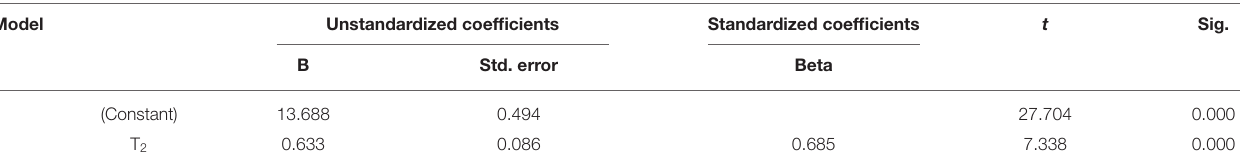
TABLE 7B | The relations between emotional valence and test scores (coefficients a )-T 2 . Model